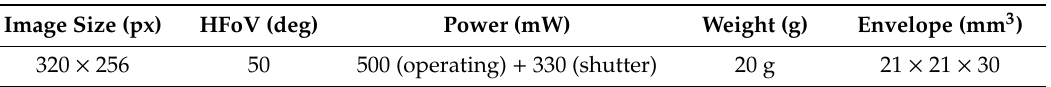
Table 1. Physical characteristics of the IR camera core, FLIR Boson 320, taken as a baseline for a microsatellite targeted implementation of our horizon sensor prototype.